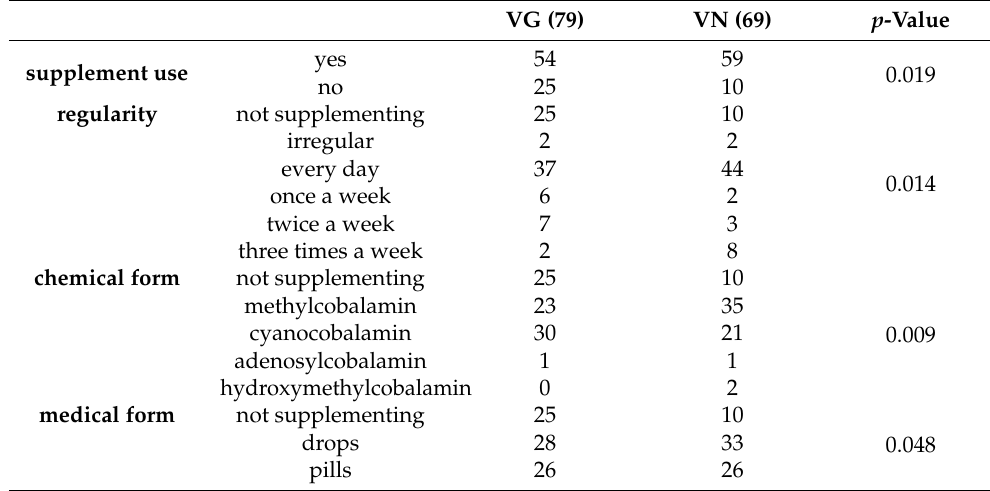
Table 6. B12 supplement habits in vegetarian (VG) and vegan (VN)